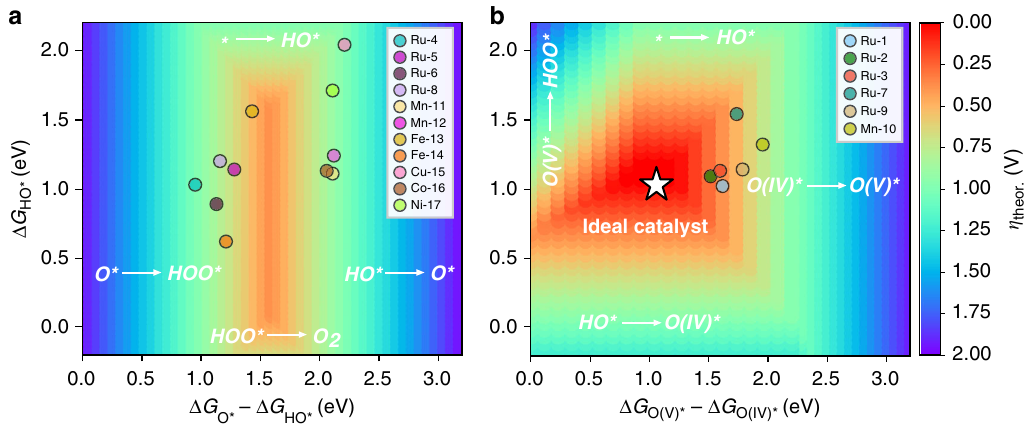
Fig. 5 Three-dimensional volcano representations including. a OER catalysts following the conventional 4-PET pathway and b catalysts theoretically predicted to undergo the additional ET step before O – O formation. The PLS on each region of the volcano plots is